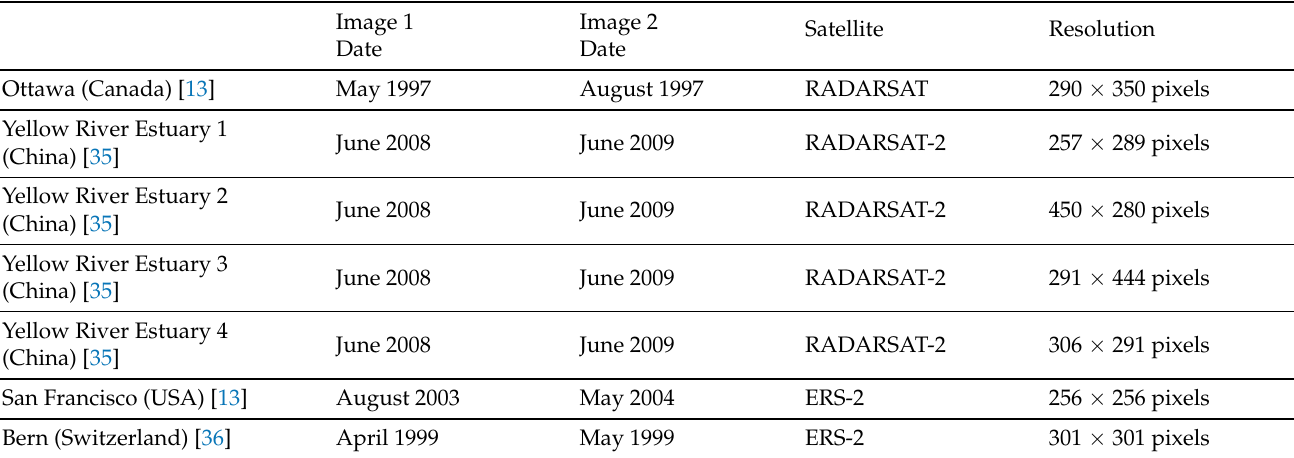
Table 1. Data Information.